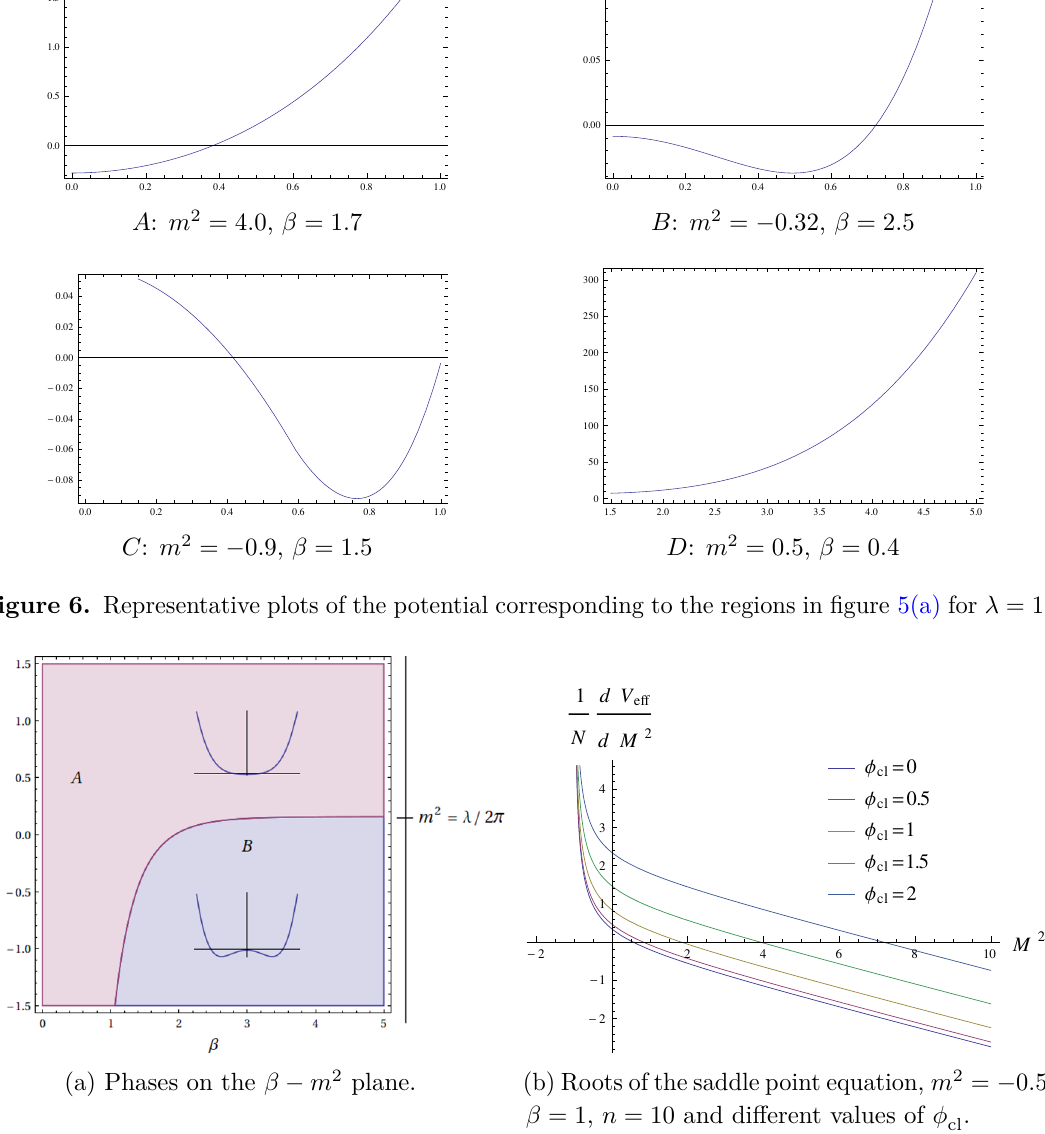
Figure 7. Phases and roots of saddle point equation for AdS 3 with positive renormalized